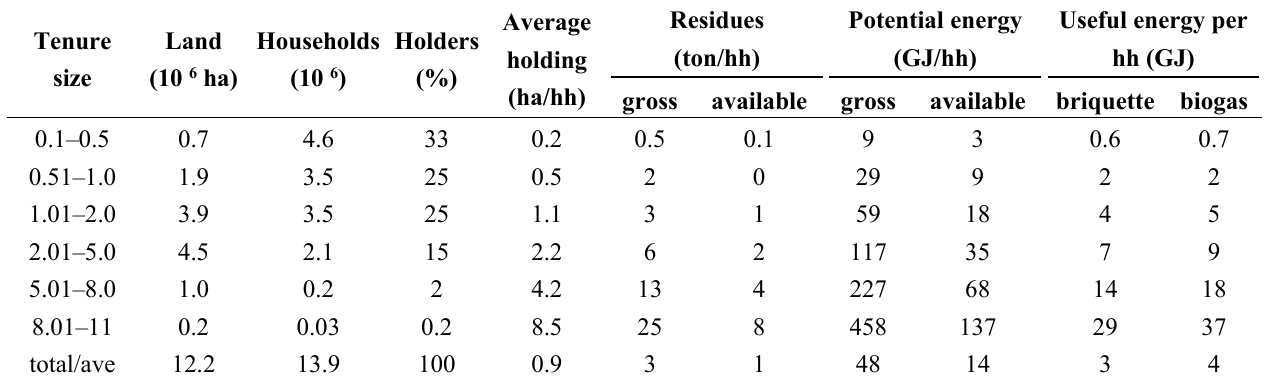
Table 5. Households’ (hh) annual energy production potential from crop residues.